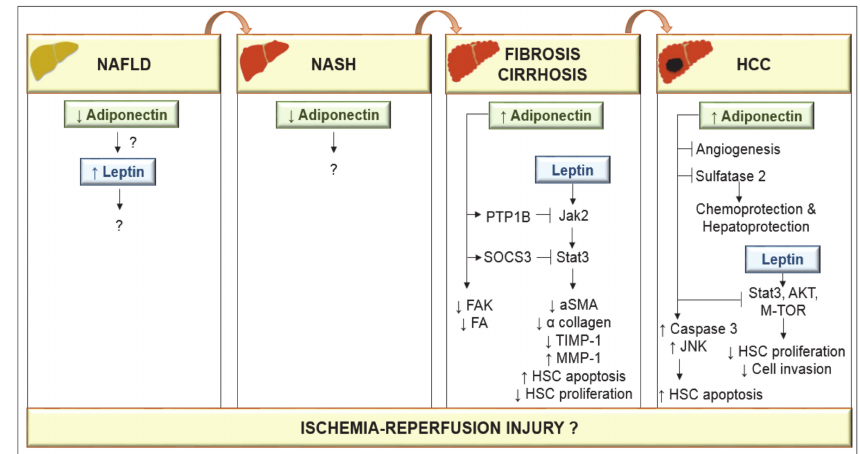
Figure 3. Adiponectin and leptin in the progression of nonalcoholic fatty liver disease (NAFLD) to hepatocellular carcinoma (HCC). Low adiponectin levels have been observed in either NAFLD or nonalcoholic steatohepatitis (NASH) conditions. However, the effects on leptin as well as the mechanisms of action of adiponectin are unknown. In cirrhosis, circulating adiponectin is elevated. Adiponectin through protein tyrosine phosphatase 1B (PTP1B) prevents the leptin-mediated activation of the janus kinase 2 (Jak2) / signal transducer and activator of transcription-3 (STAT3) pathway through suppressors of cytokine signaling 3 (SOCS3) and the activity of focal adhesion kinase (FAK) and focal adhesion (FA). By inducing SOCS3, adiponectin suppresses leptin activity. Adiponectin can provoke hepatic stellate cells (HSC) apoptosis and leads to the loss of α -smooth muscle actin ( α -SMA) proteins in HSCs and suppresses HSC proliferation and α collagen biosynthesis. Adiponectin-mediated prevention of leptin signaling downregulates tissue inhibitor of metalloproteinase 1 (TIMP-1) activity and increases matrix metalloproteinase 1 (MMP-1) to degrade fibrillar collagen in matrix. Adiponectin increases apoptosis of HCC cells via activation of caspase-3, and c-Jun N-terminal kinase (JNK). Adiponectin inhibits leptin-induced proliferation of HCC via blockade of STAT-3, protein kinase B (AKT) and mammalian target of rapamycin (m-TOR) and shows hepatoprotective functions by blocking angiogenesis and sulfatase